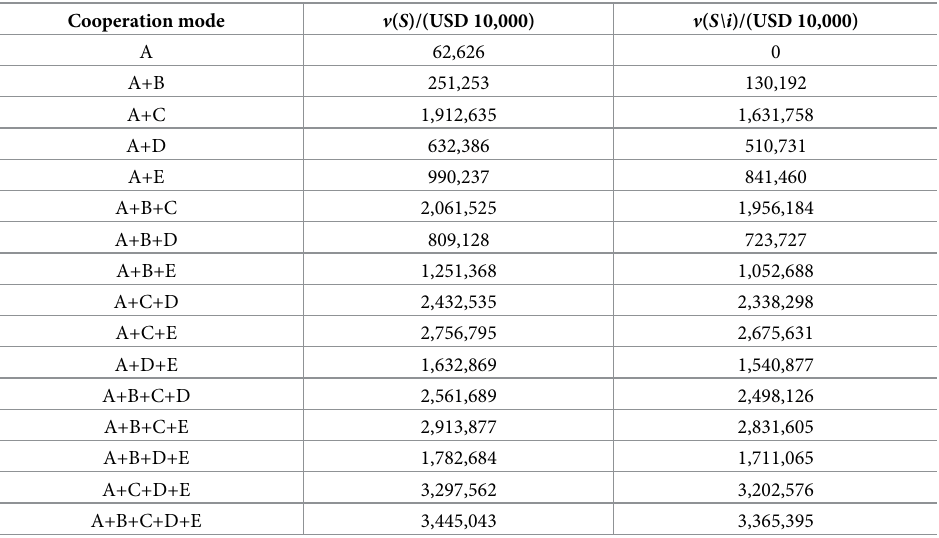
Table 6. Profits of China and other countries at 90% water inflow. Cooperation